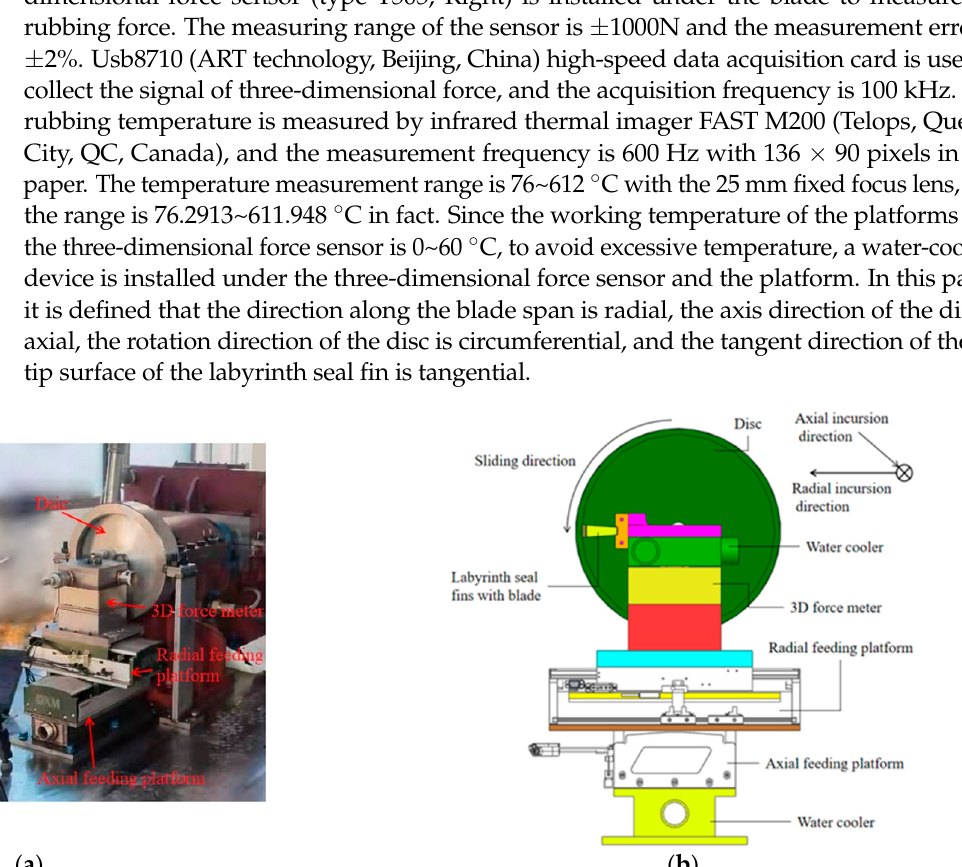
Figure 3. Installation of honeycomb.